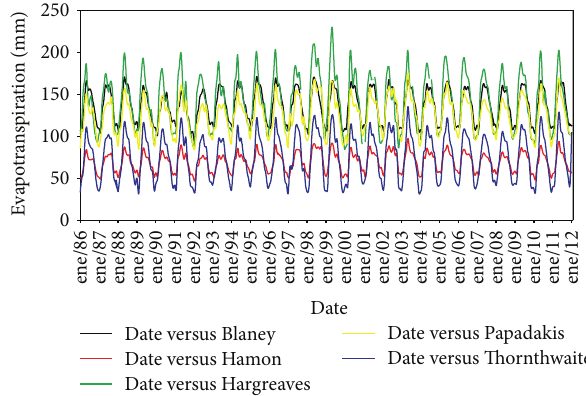
Figure 7: Estimates of potential evapotranspiration for station 22006.